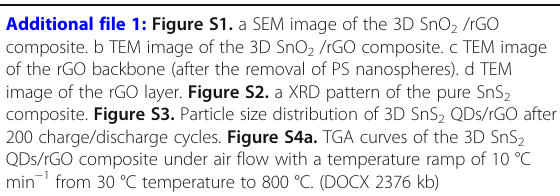
Additional file 1: Figure S1. a SEM image of the 3D SnO 2 /rGO composite. b TEM image of the 3D SnO 2 /rGO composite. c TEM image of the rGO backbone (after the removal of PS nanospheres). d TEM image of the rGO layer. Figure S2. a XRD pattern of the pure SnS 2 composite. Figure S3. Particle size distribution of 3D SnS 2 QDs/rGO after 200 charge/discharge cycles. Figure S4a. TGA curves of the 3D SnS 2 QDs/rGO composite under air flow with a temperature ramp of 10 °C min − 1 from 30 °C temperature to 800 °C. (DOCX 2376